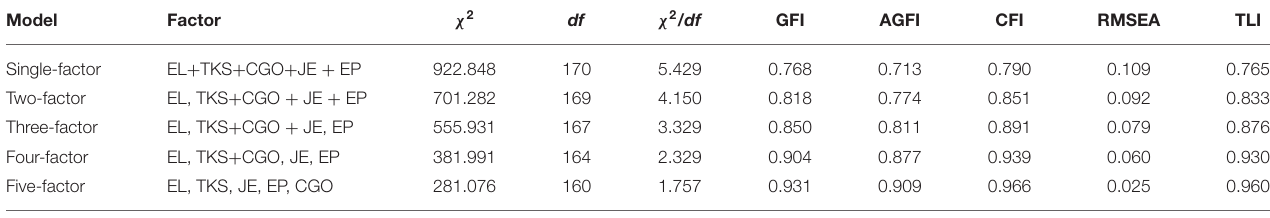
TABLE 1 | Confirmatory factor analysis results. Model